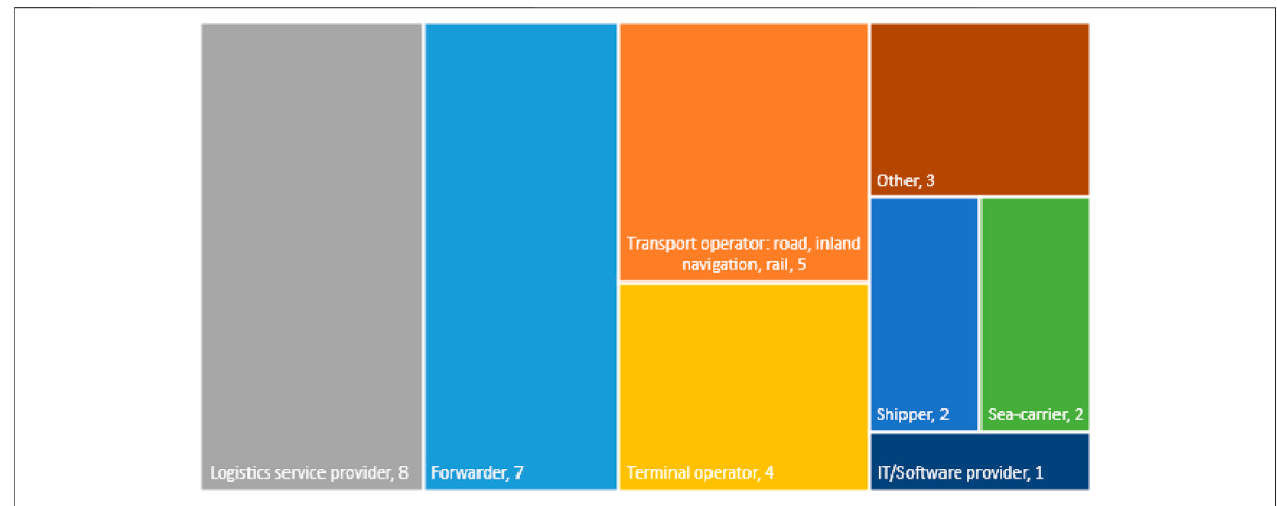
FIGURE 1 | Share of logistics and port stakeholders participating in the survey.